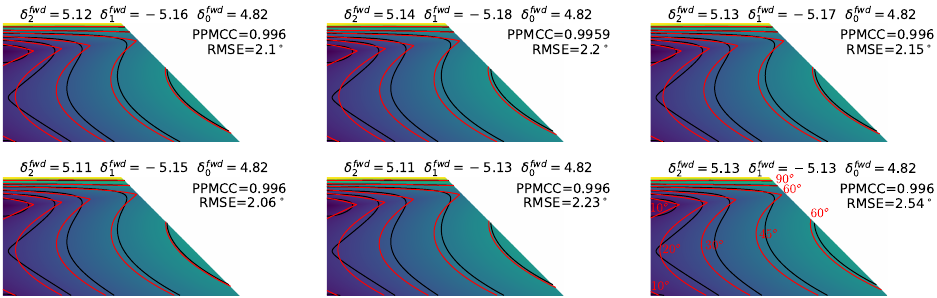
Figure 12. Distribution and contours (in red) of FWD–GCA metric for evaluating Eckert II projection using rational function–based regression with different regression